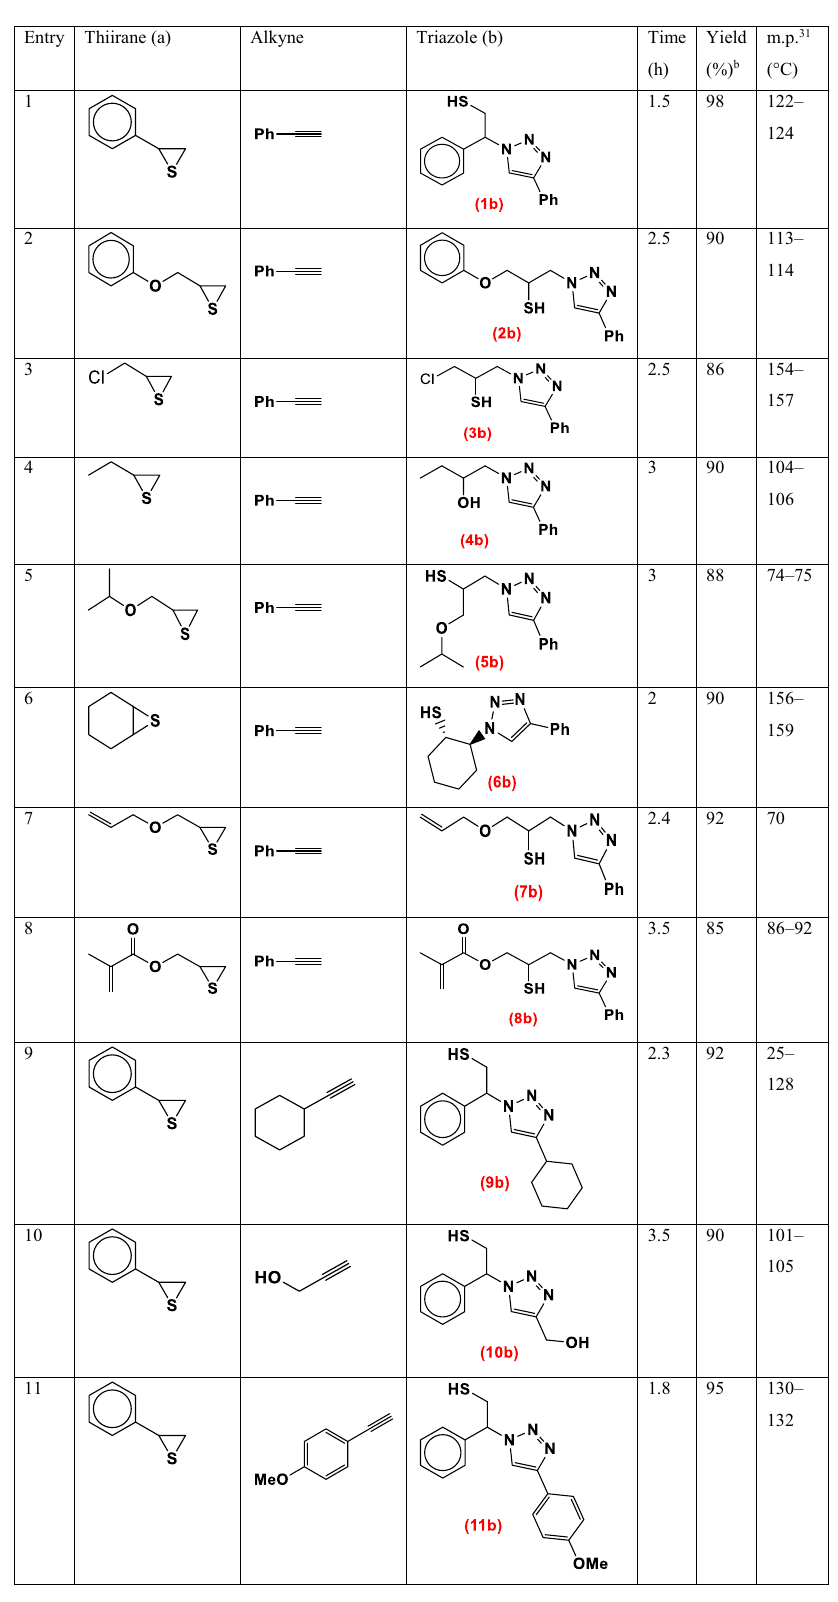
Table 3. Synthesis of β -thiol-1,2,3-triazoles from thiiranes in the presence of Fe 3 O 4 @SiO 2 -PMA-Cu nanocatalyst. All reactions were performed with of thiirane (1 mmol), alkyne (1 mmol), sodium